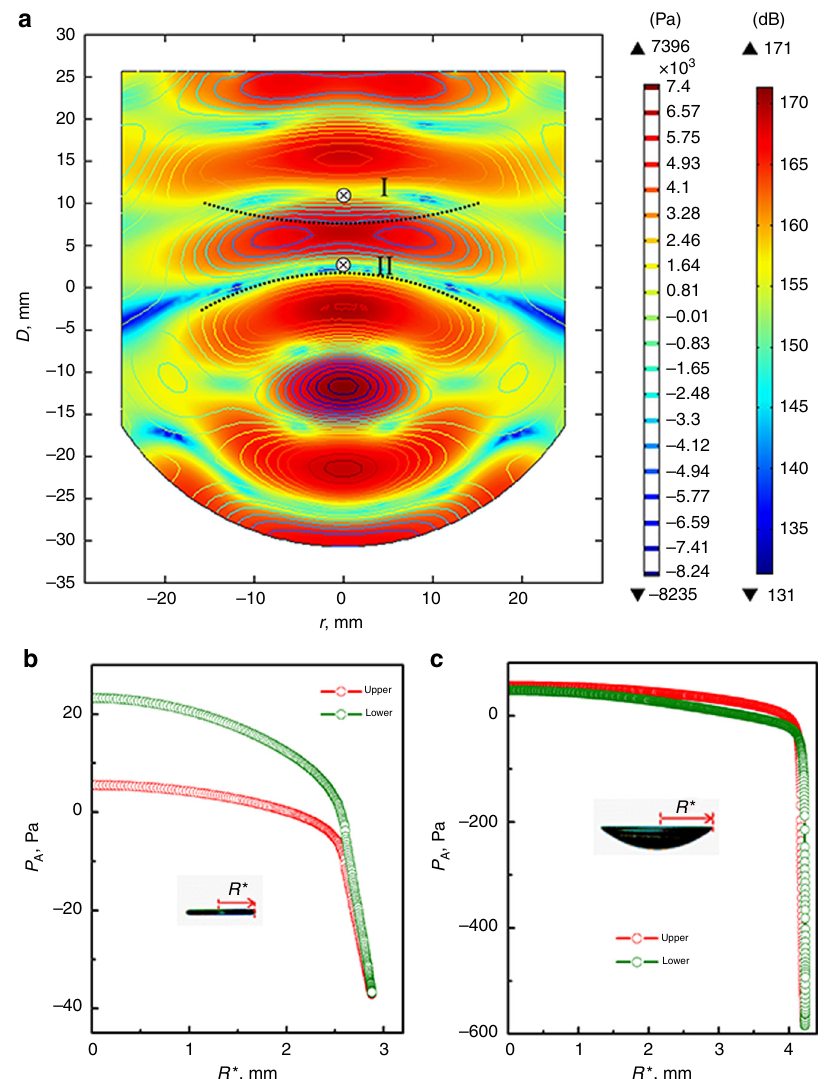
Fig. 2 Sound fi eld and acoustic radiation pressure calculation. a Distribution of sound pressure fi eld in levitator with no levitated sample. Distance between emitter and re fl ector D is 40.0 mm corresponding to the initiation of liquid fi lm buckling and r is the cross-sectional radius of the re fl ector. Sound pressure level at the center of the emitter surface is 155.7 dB. Black cross denotes the sound pressure nodes of the sound fi eld, i.e. possible levitation positions under zero gravity. Levitation positions under normal gravity are below the crosses. Dotted lines indicate curvatures of equipotential surfaces close to positions I and II. b and c Acoustic radiation pressure P A exerted on the liquid fi lm surfaces (aqueous SDS drop, 10 μ L) as a function of R * shown in inset: b fl at liquid fi lm, showing that P fi lm, showing that P A is larger on the lower surface, c buckled liquid A on the upper surface becomes greater and is therefore responsible for the enhanced